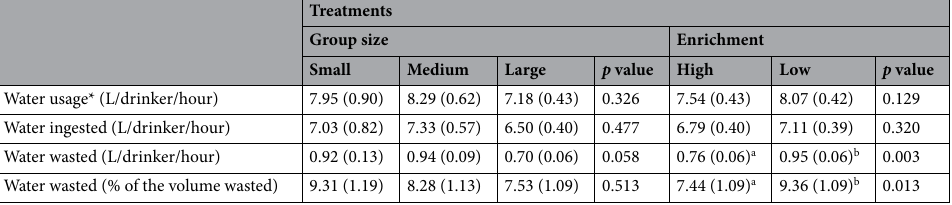
Table 2. LS means (SEM) of the effect of group size and enrichment on the water usage, water ingested and water wasted from 0930 to 1600 h. Group size: Large (48 pigs/pen), Medium (24 pigs/pen), Small (12 pigs/ pen). Enrichment: Low (Wood + Hanging toy), High (Wood + Hanging toy + Grass). abc Different letters denote